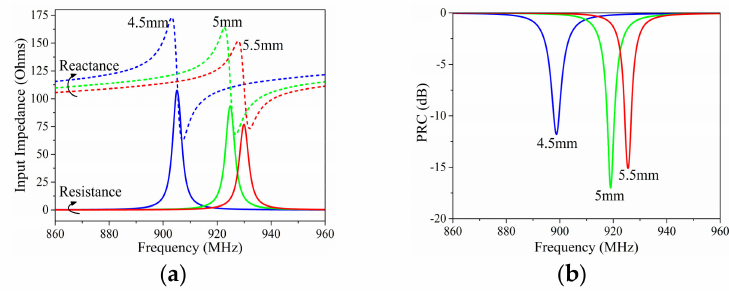
Figure 7. Simulated ( a ) input impedance and ( b ) PRC results with di ff erent lengths of Rp .